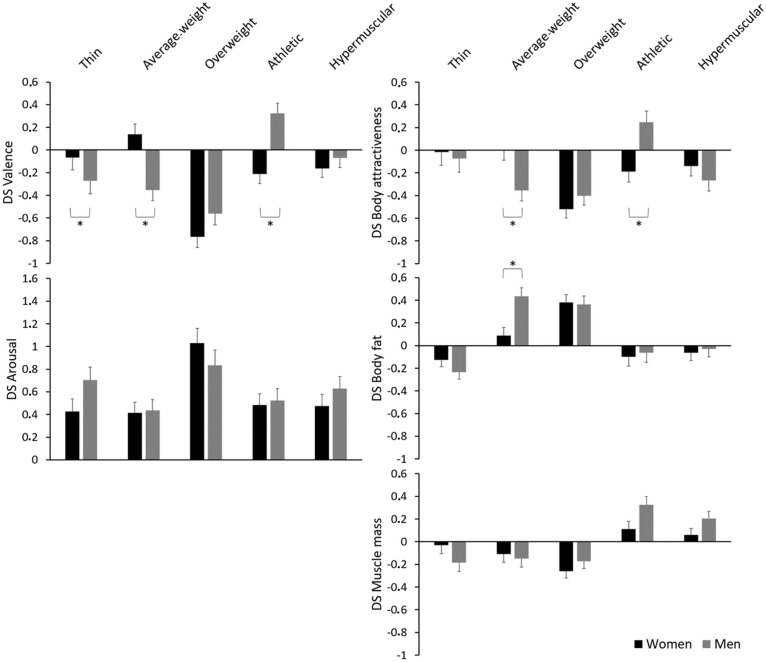
Means and standard errors (error bars) for the double standard scores (DS scores) for valence, arousal, body attractiveness, body fat and muscle mass dependent on the factors Group and Build. Asterisks highlight significant Bonferroni-corrected group differences.